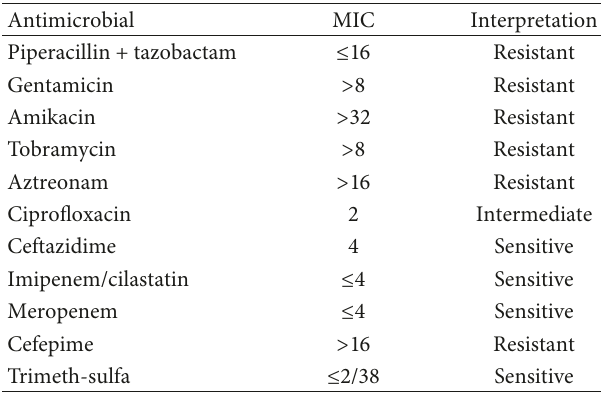
Table 1: The antibiotic sensitivity